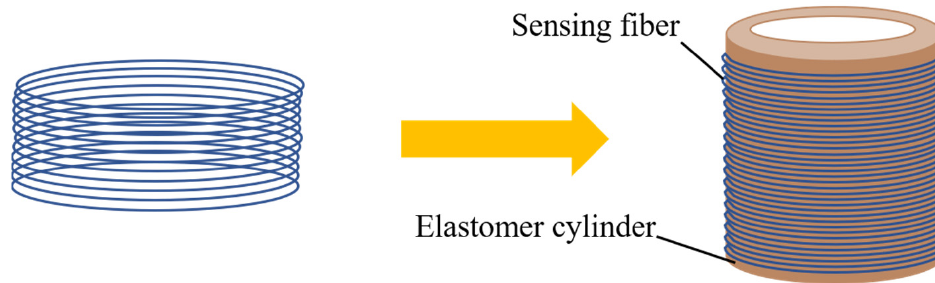
Figure 2. The schematic diagram of the straight line-type Sagnac fiber optic acoustic sensor.